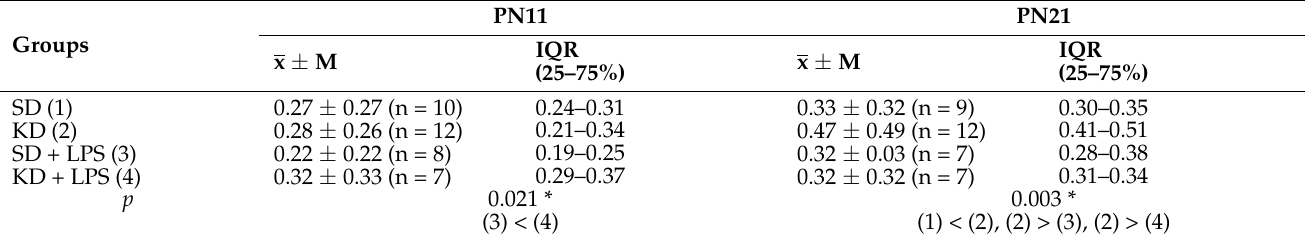
Table 6. Brain weights (g) in the